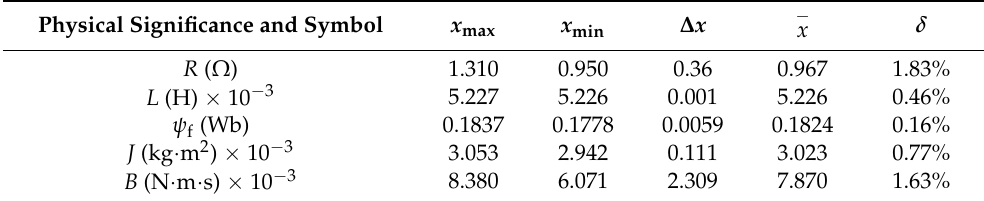
Table 4. Multiparameter identification of the PMSM result based on the MRAS-PSO algorithm.